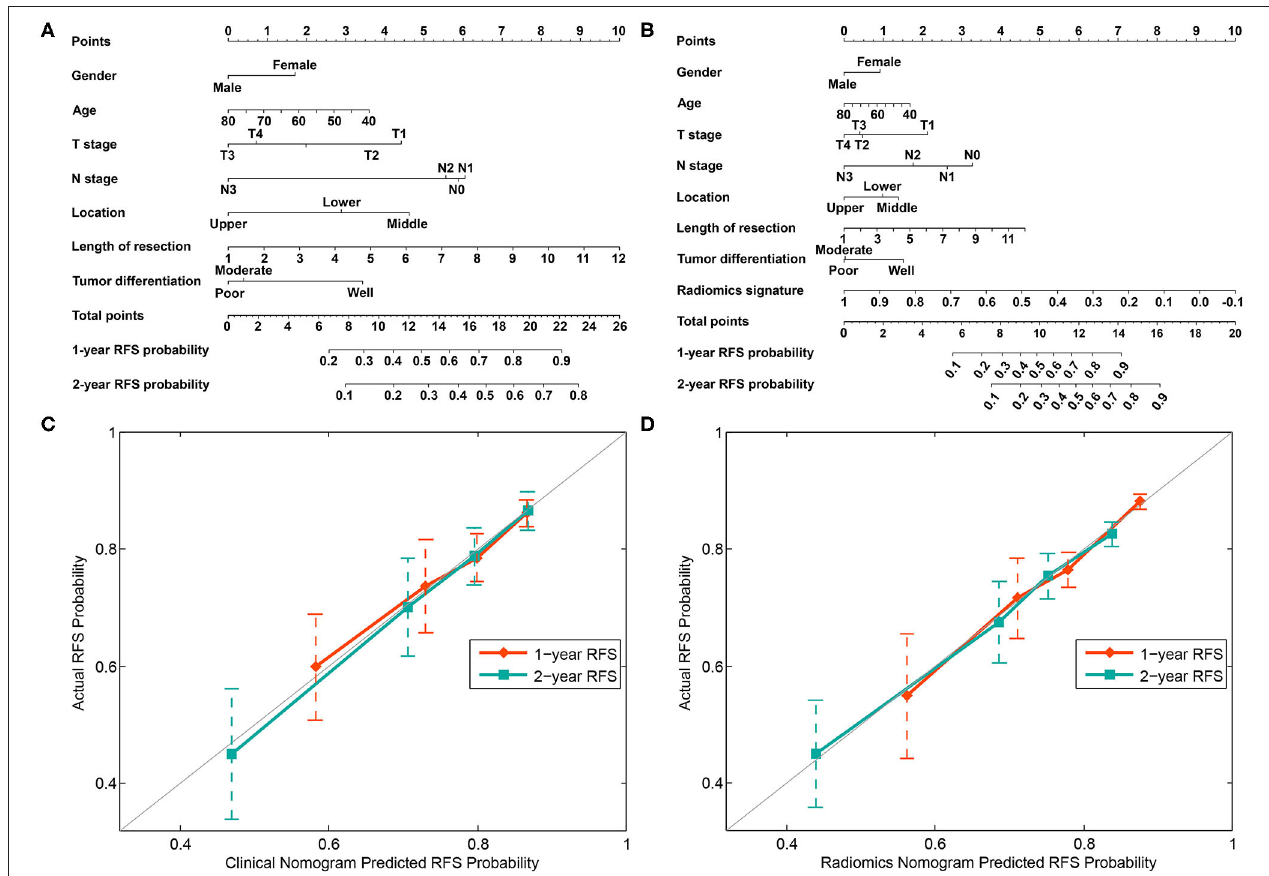
FIGURE 4 | Nomograms developed using the training cohort. (A) The nomogram incorporates clinical risk factors. (B) The nomogram incorporates the radiomics signature and clinical risk factors. Calibration curves of the clinical nomogram (C) and radiomics nomogram (D) were plotted to assess the agreement between RFS probability predicted by the nomogram and the observed RFS.